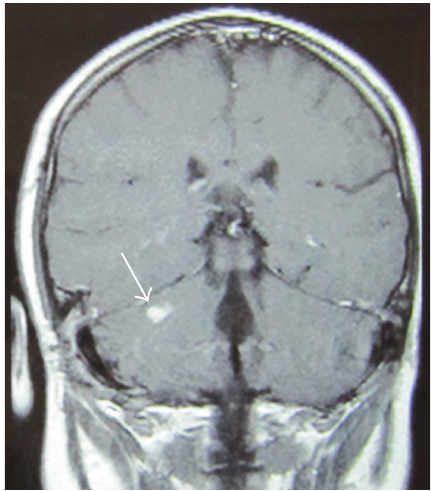
Figure 3: Only a small residual lesion (arrow) is observed, two months after the drainage of the cerebellar